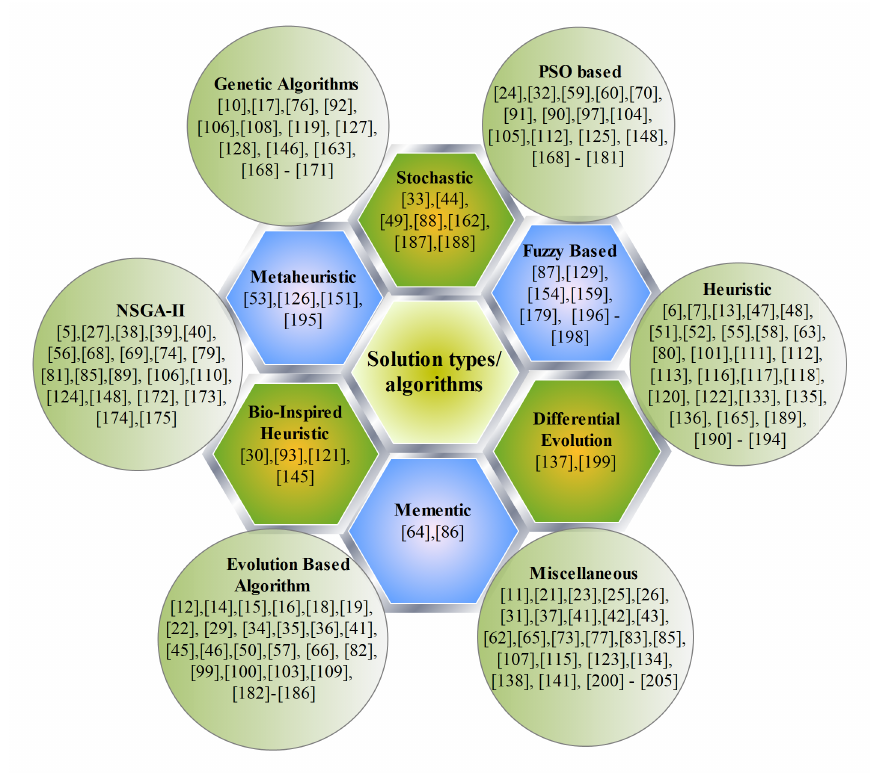
Figure 5. Different Types of Solution